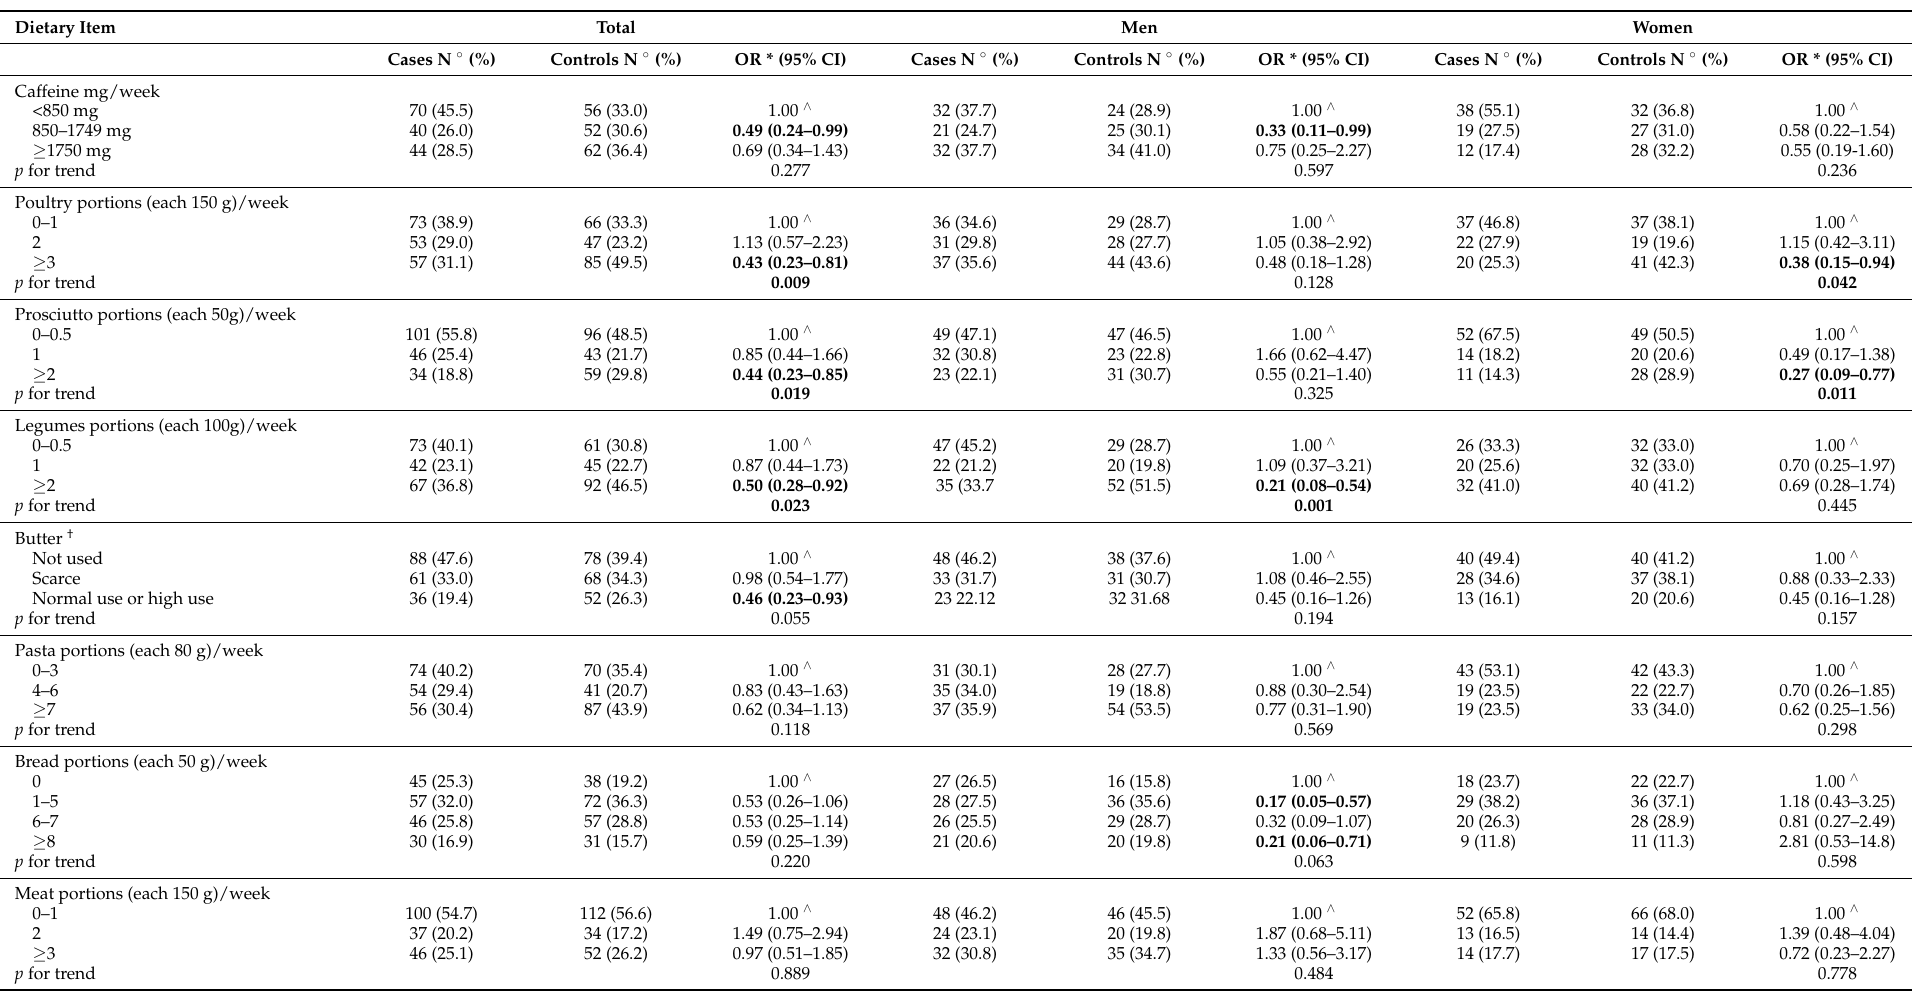
Table 1. Distribution of 185 cases with incident diagnosis of tinnitus and 198 controls, overall and stratified by sex, according to selected dietary habits. Odds ratios (OR) and corresponding 95% confidence intervals (CI) for cases with tinnitus vs. controls. Italy,